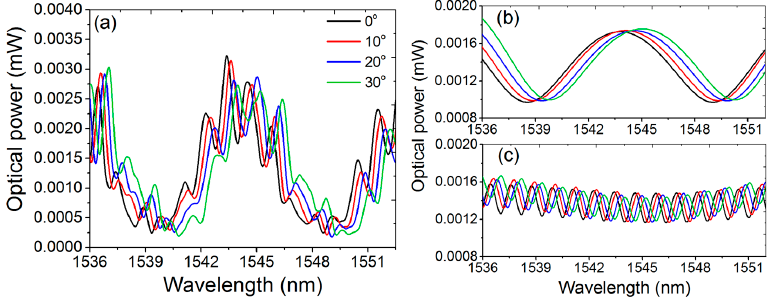
Figure 4. For a particular x -polarization case: ( a ) transmission spectrum of the fiber m-MZI using ATC-PCF ( L ~ 5.1 cm) under the applied torsions, and the corresponding demodulated optical spectra of the constituent ( b ) inter-core (P 1 ); and ( c ) inter-modal (P 3 ) interferometers.